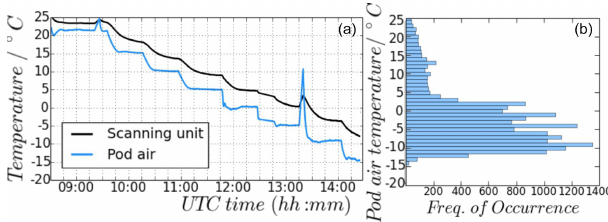
Figure 4. Temperature sensor measurements during cold-chamber measurements ( a ; black line: scanning unit sensor, blue line: pod air sensor). At 0 ◦ C ( ∼ 11:45UTC) the cold-chamber software had to be restarted, causing a longer stabilization period, and at − 5 ◦ C ( ∼ 13:15UTC) the cold chamber was opened to refill the liquid ni- trogen in the cold target, causing spikes in the temperature measure- ment. (b) Pod air temperature measurements during all ML CIR- RUS campaign